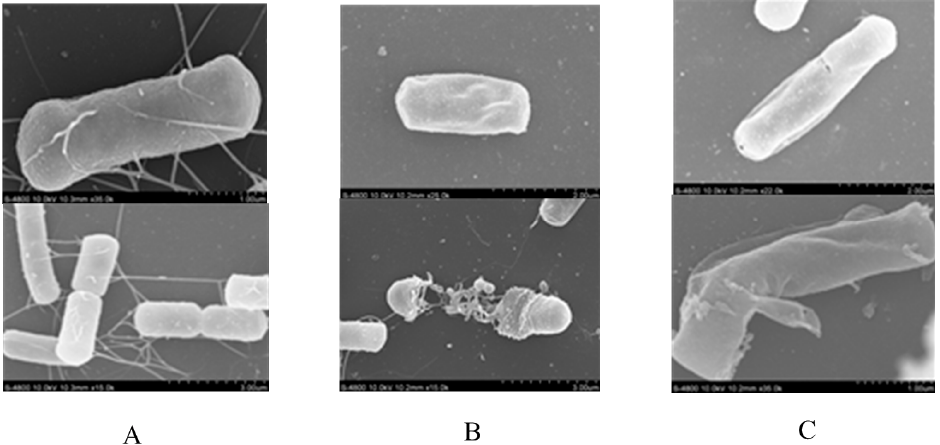
Figure 3. Scanning Electron Microscope (SEM) photography of B. cereus. ( A ) Blank control; ( B ) Positive control (treated with yanglingmycin); ( C ) Treated with Compound 7h .